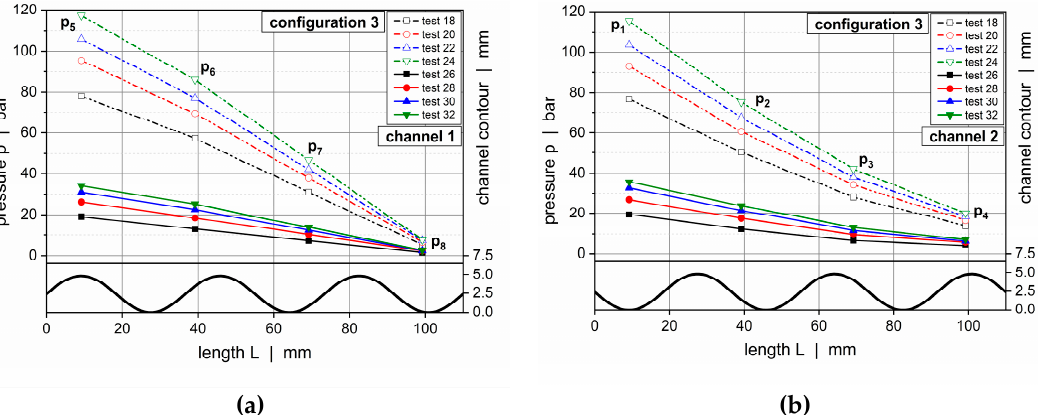
Figure 16. Down-channel pressure profiles along channel 1 ( a ) and channel 2 ( b ) for HDPE and PP-R for configuration 3.